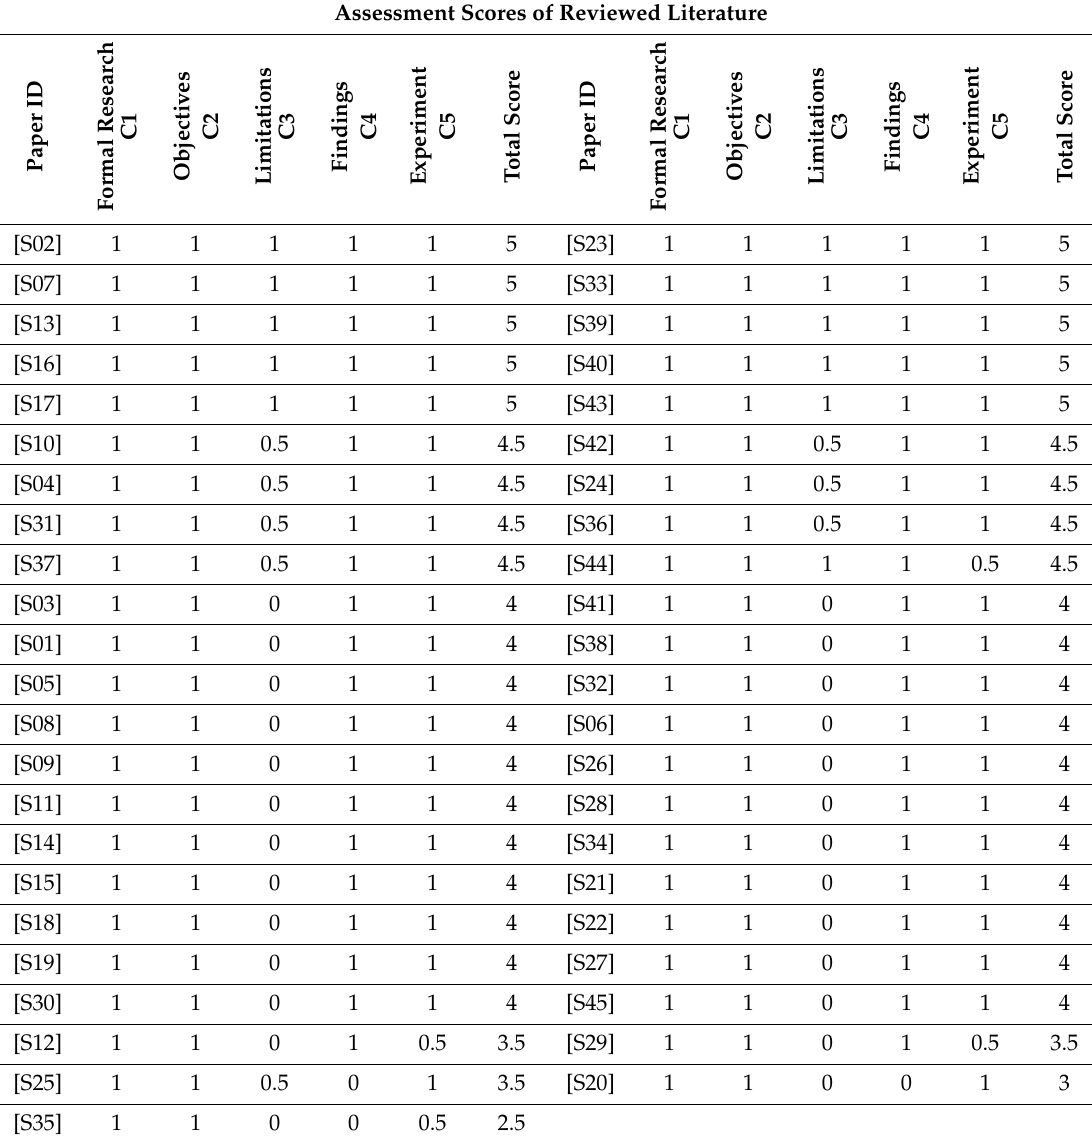
Table 10. Assessment scores of reviewed literature.